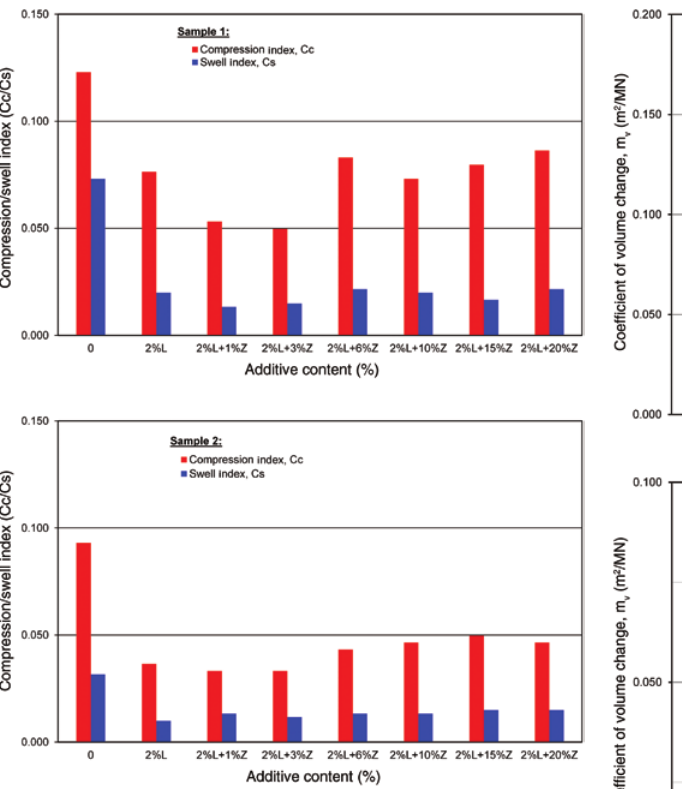
Figure 7: Relationship between compression index (Cc) and swell index (Cs) of the soil samples depending on additive